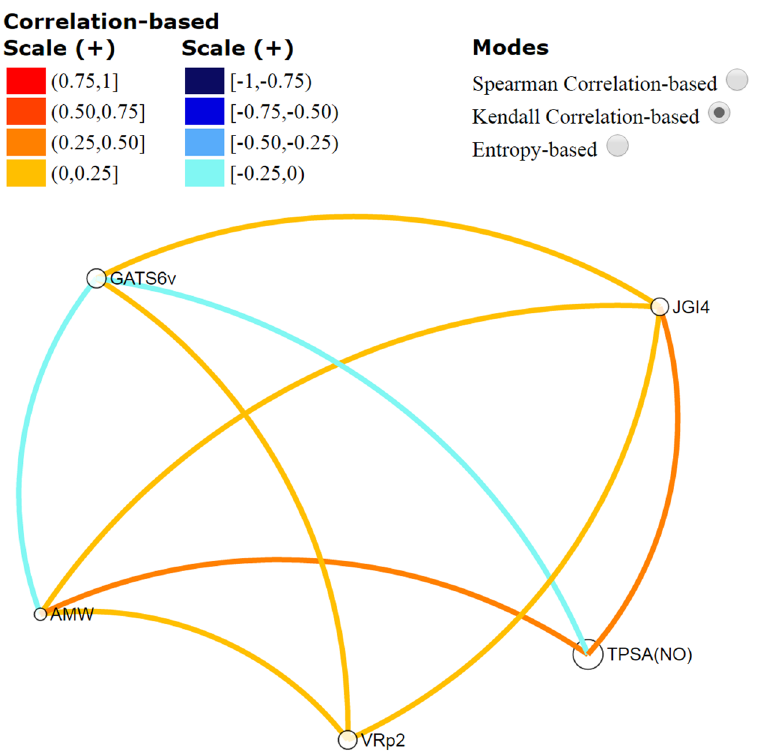
Figure 6. Correlation analysis among the molecular descriptors that conforms the model M9 HIA